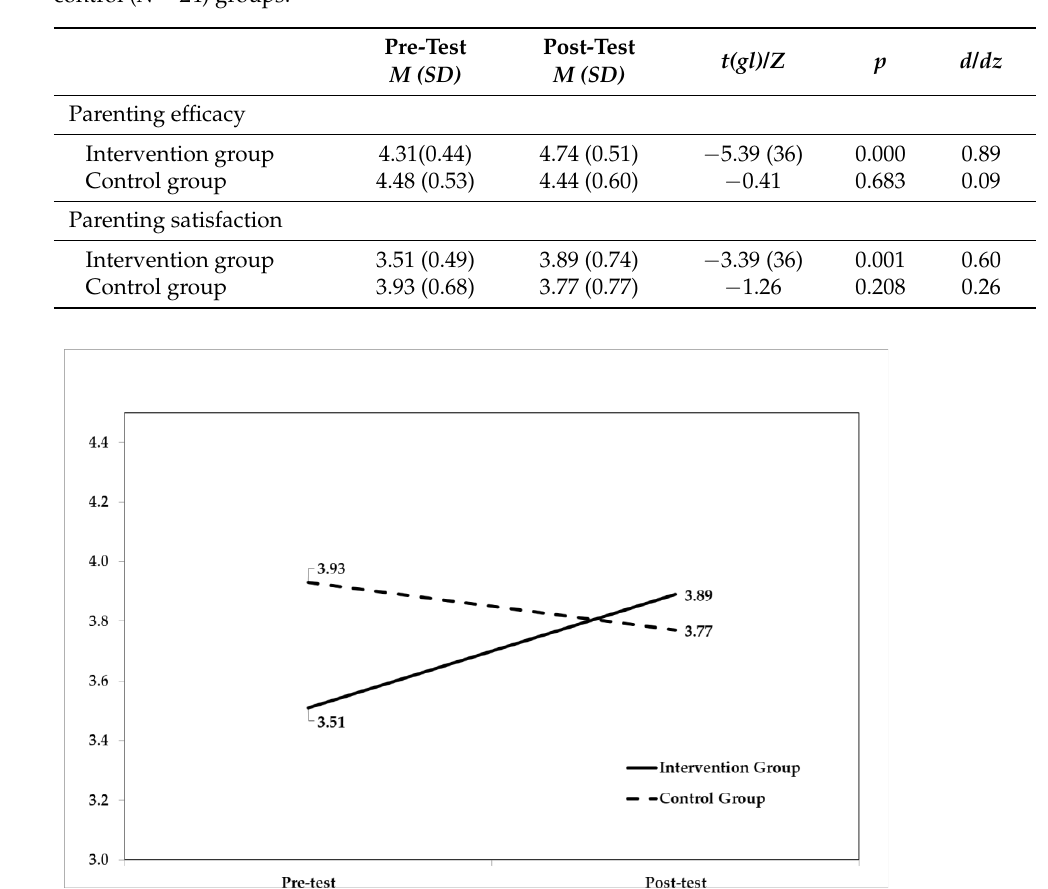
Figure 3. Parenting satisfaction in intervention and control groups in pre-test and post-test.